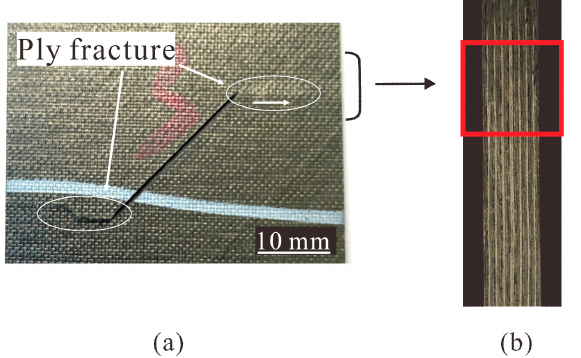
Figure 15. Compression failure modes of specimens (S3-2) with shallow surface cracks, ( a ) surface fracture, ( b ) failure mode (observed from the side).